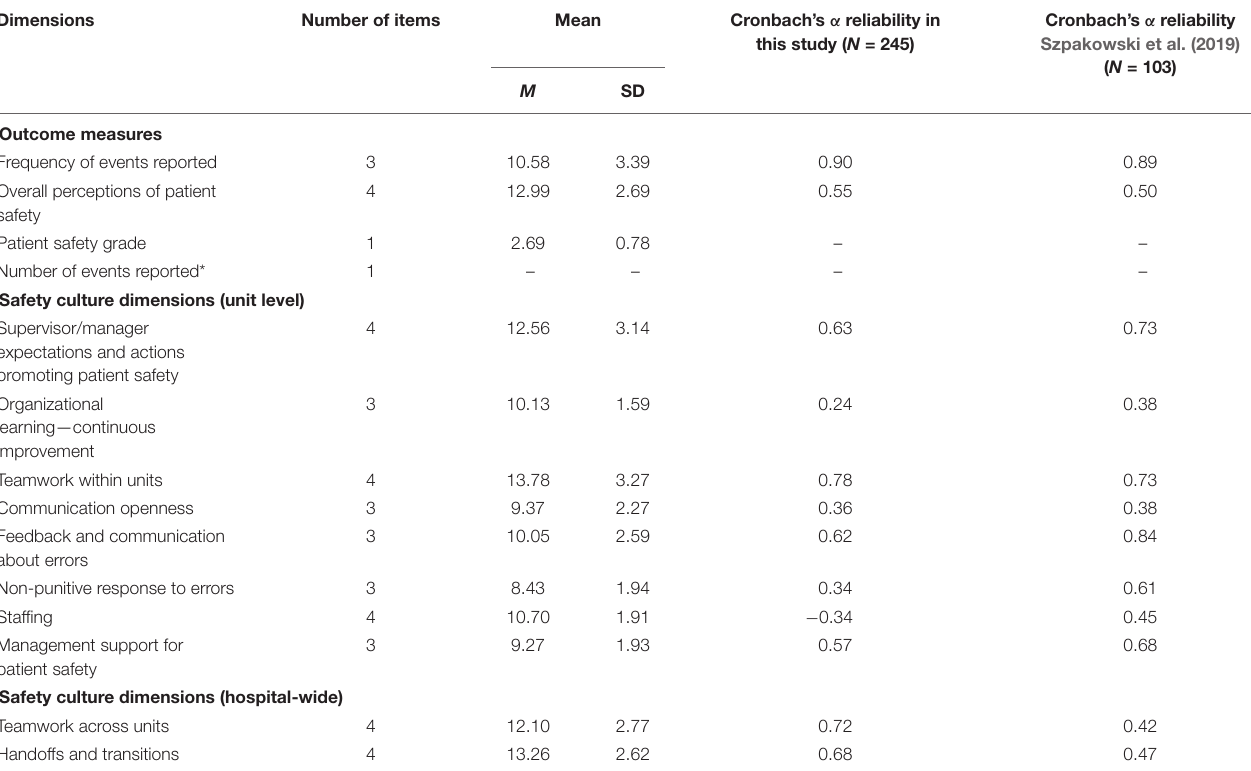
TABLE 2 | Descriptive statistics, structure and results of reliability analysis of 12 dimensions of the questionnaire ( N = 245).